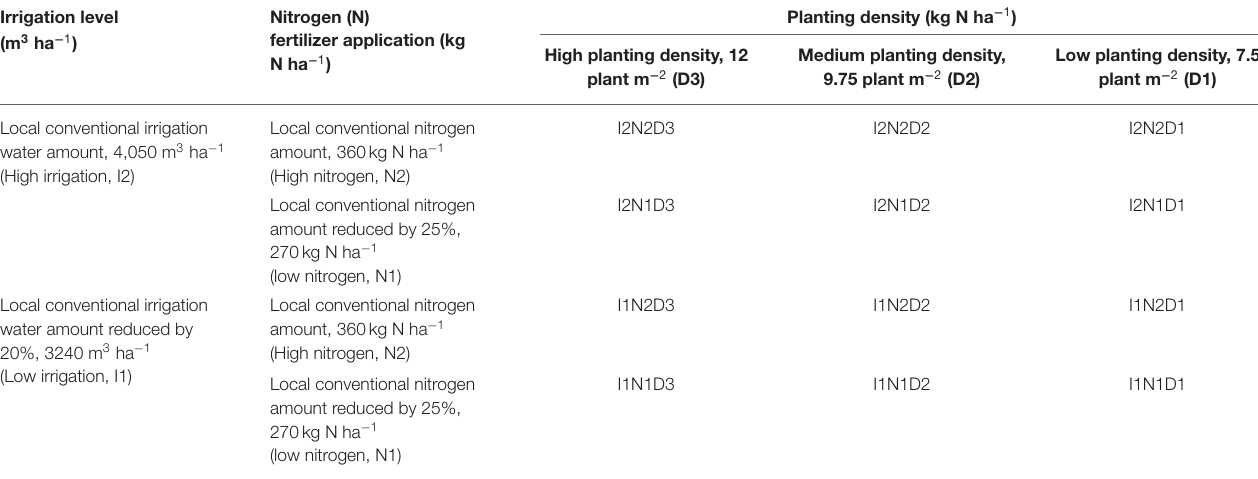
TABLE 1 | Description of experimental